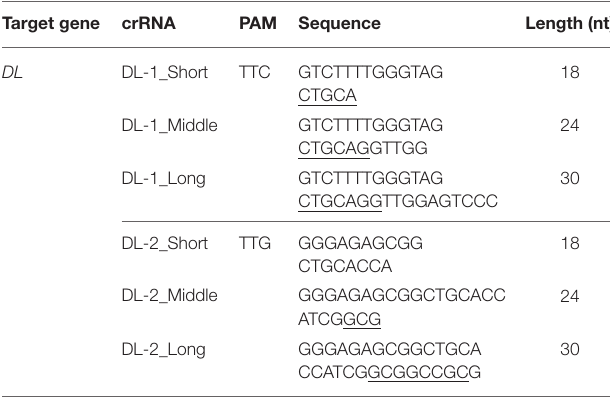
TABLE 1 | Target sequences and lengths of DL-1 and DL-2. Target gene